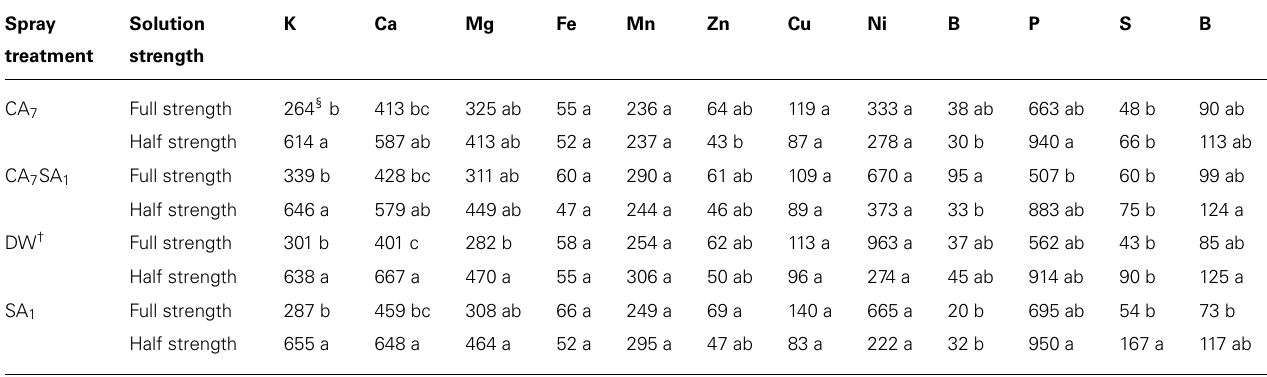
Table 2 |The effect of combinations of salicylic acid and citric acid on mineral accumulation ratio in plant vs. nutrient solution (fresh weight basis). Spray